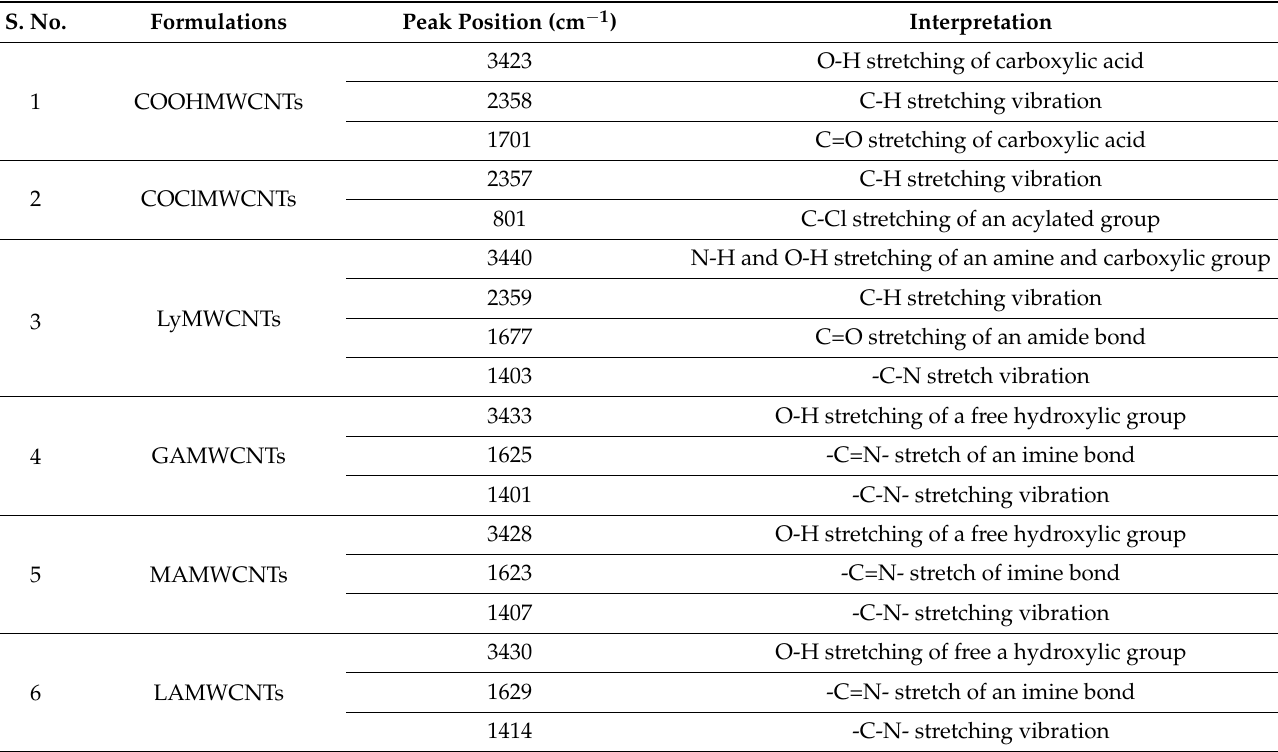
Table 1. FT-IR interpretation of the multiple functionalized